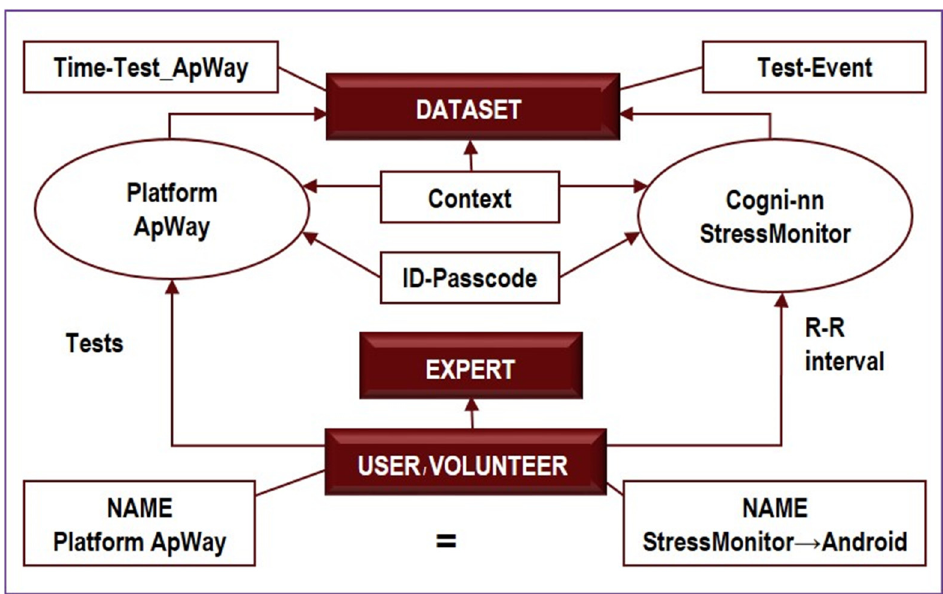
Figure 5. The architecture of the event-driven telemetry.